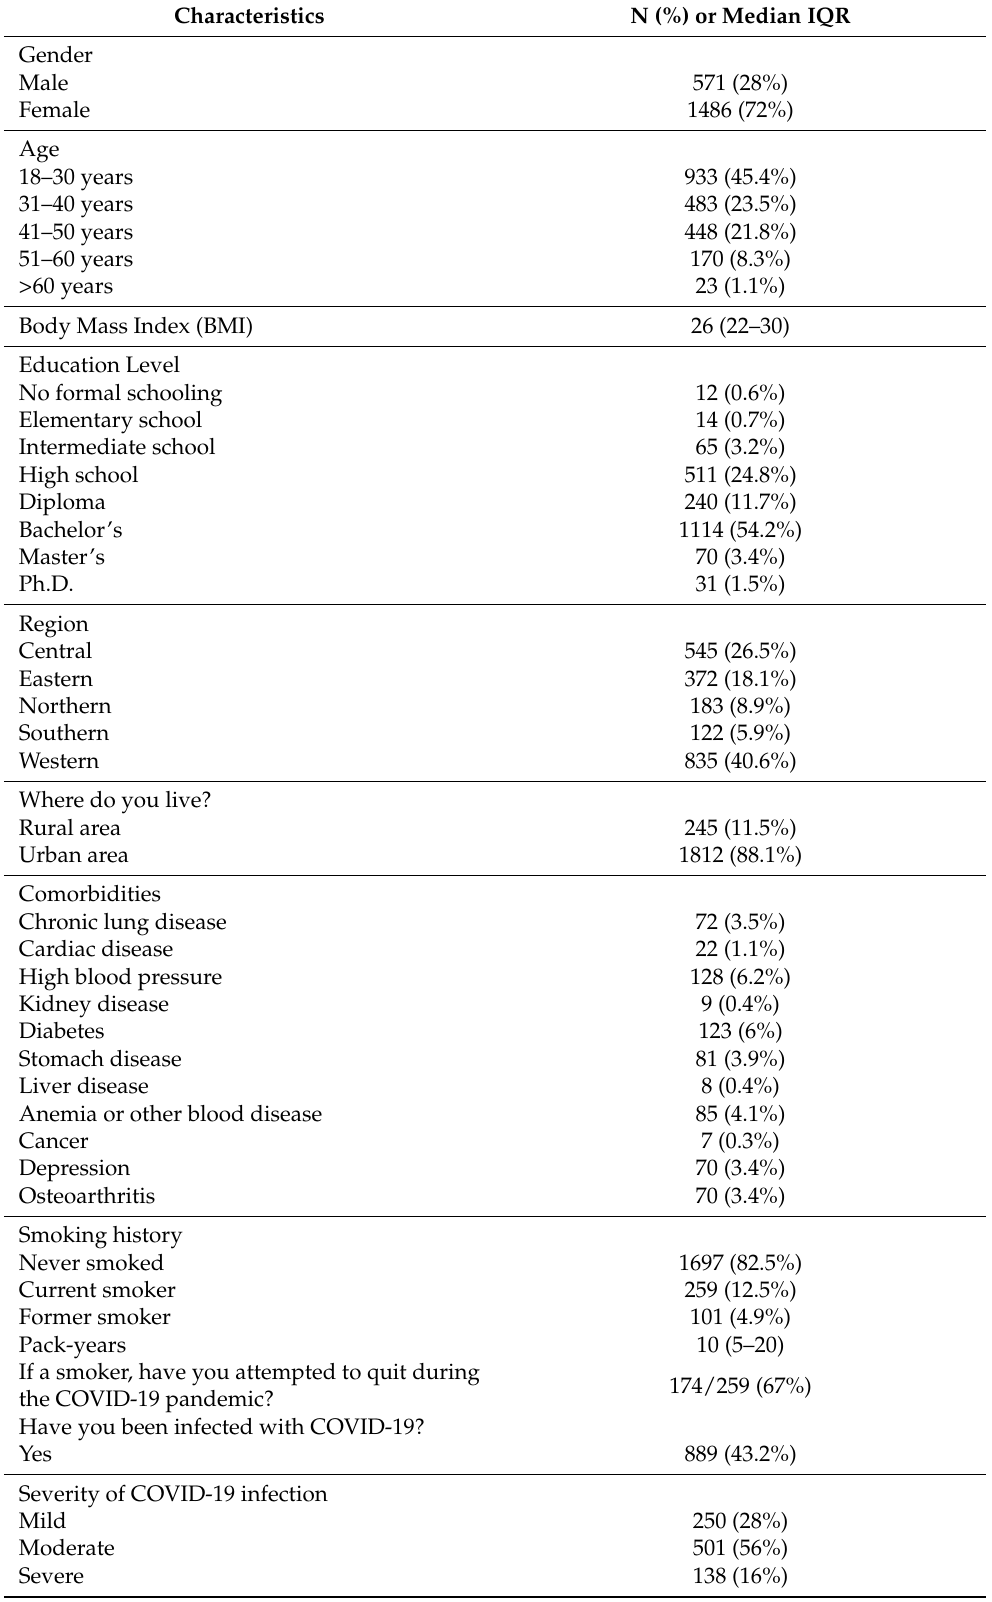
Table 1. Characteristics of the